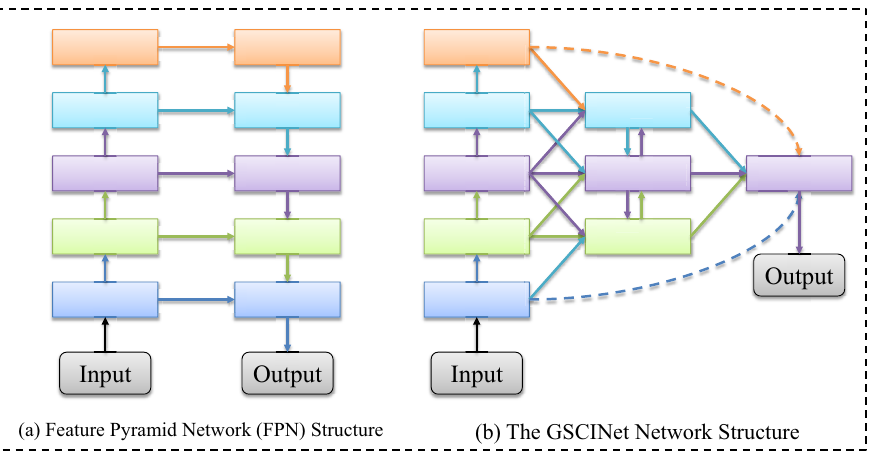
Figure 2. Illustration of different network structures. Left to right column: Feature Pyramid Network (FPN) [19] and Our GSCINet Network structures are depicted,